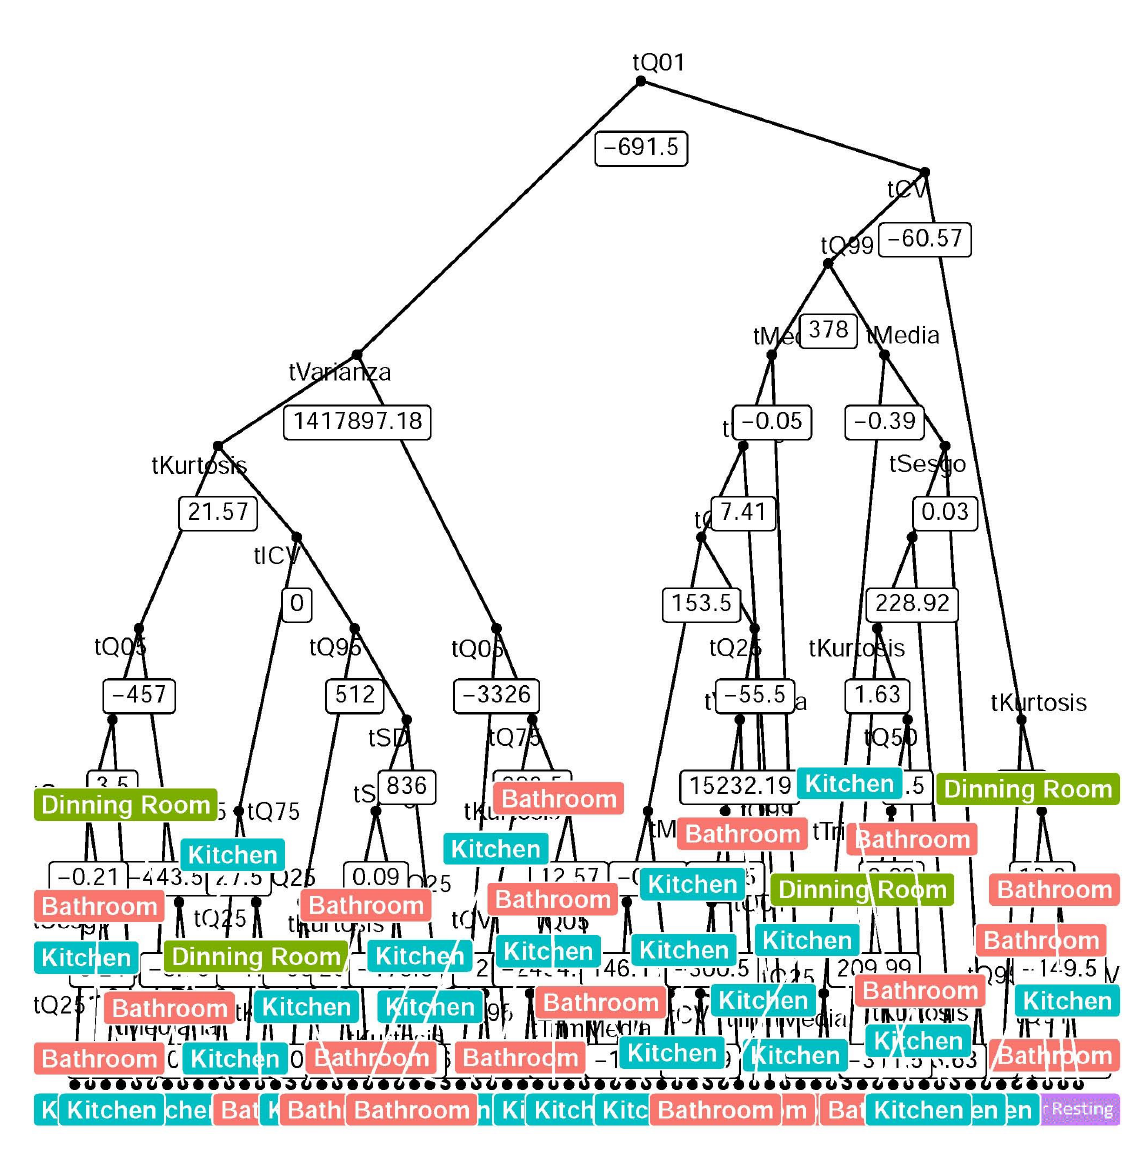
Figure 4. Minimal features tree from 500 trees generated by the random forest algorithm.